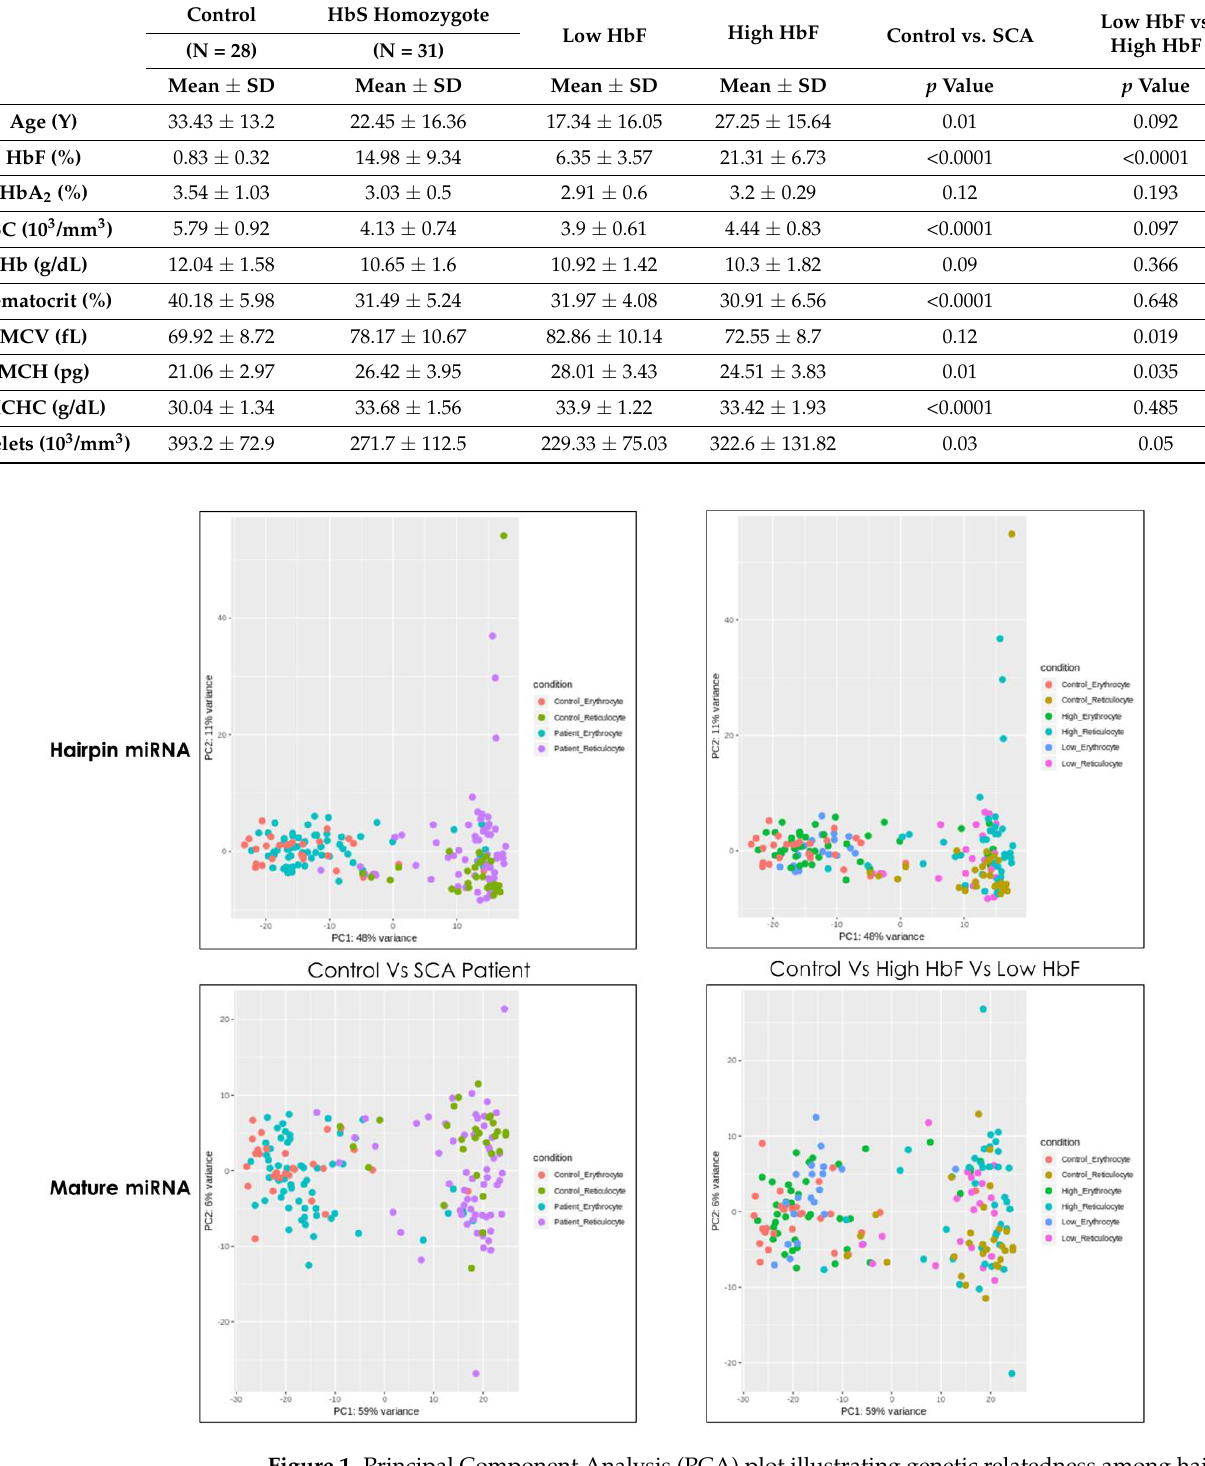
Figure 1. Principal Component Analysis (PCA) plot illustrating genetic relatedness among hairpin and mature miRNA in study cohort.